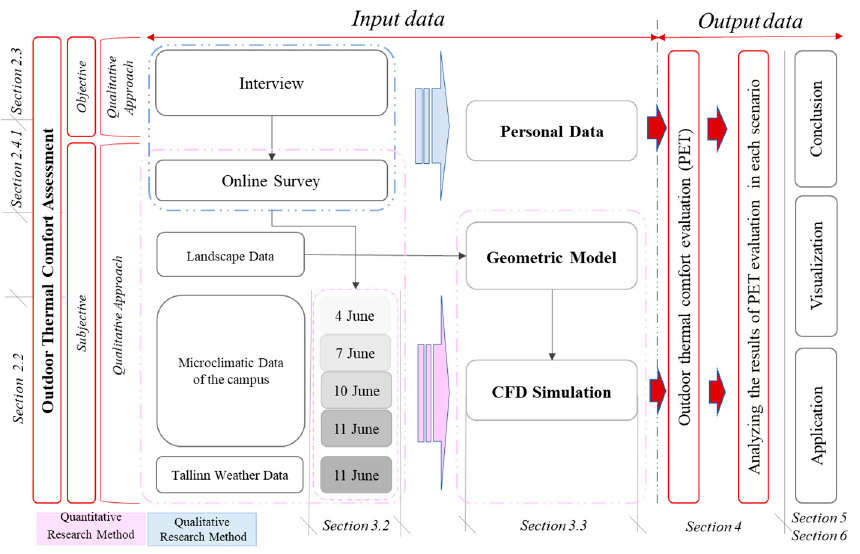
Figure 1. The framework proposed in this investigation.